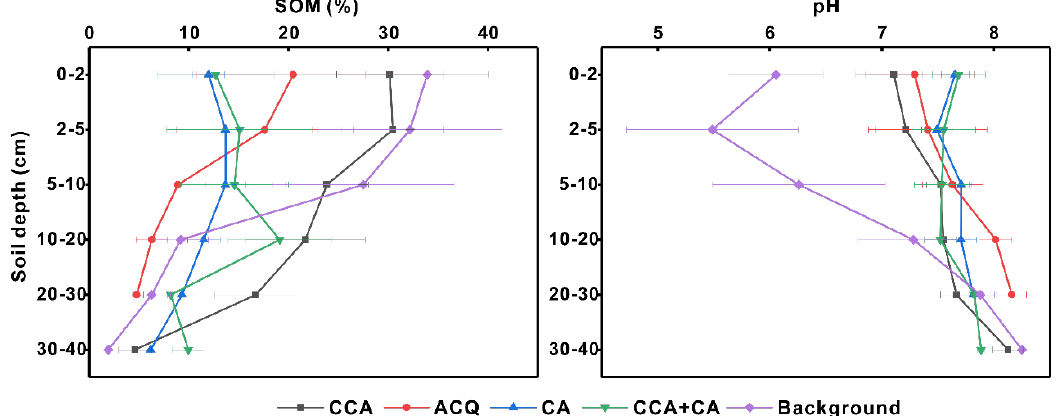
Figure 2. Averaged SOM and pH values within soil profiles under different preservative – treated Figure 2. boardwalks.